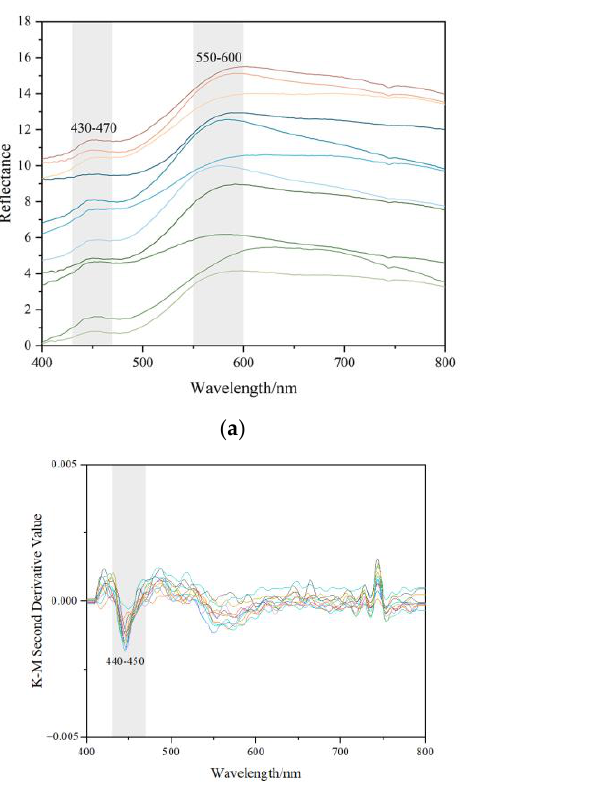
11 of 17 Figure 9. Projection of samples’ colour parameters in the CIE 1931 L*a*b* standard space, and it can be seen that the yellow and orange-yellow areas were mainly concentrated in two different zones. 3.4. UV-Vis Reflectance Spectra All figures and tables show that yellow and orange-yellow are the characteristic col- our of the yellow seal stones from northern Laos. The orange-yellow part is closer to the surface of a sample than the yellow part in the same sample. Therefore, the UV-Vis spectra of all the samples were collected at the yellow and orange-yellow matrix parts to analyse colour parameters and attain DRS, then to analyse the correlation of colour and iron ox- ides. Figure 10 shows several UV-Vis characteristic spectra of the two colour groups, yel- low and orange-yellow. There are two main bands in the wavelength of 400~800 nm, which are at about 450